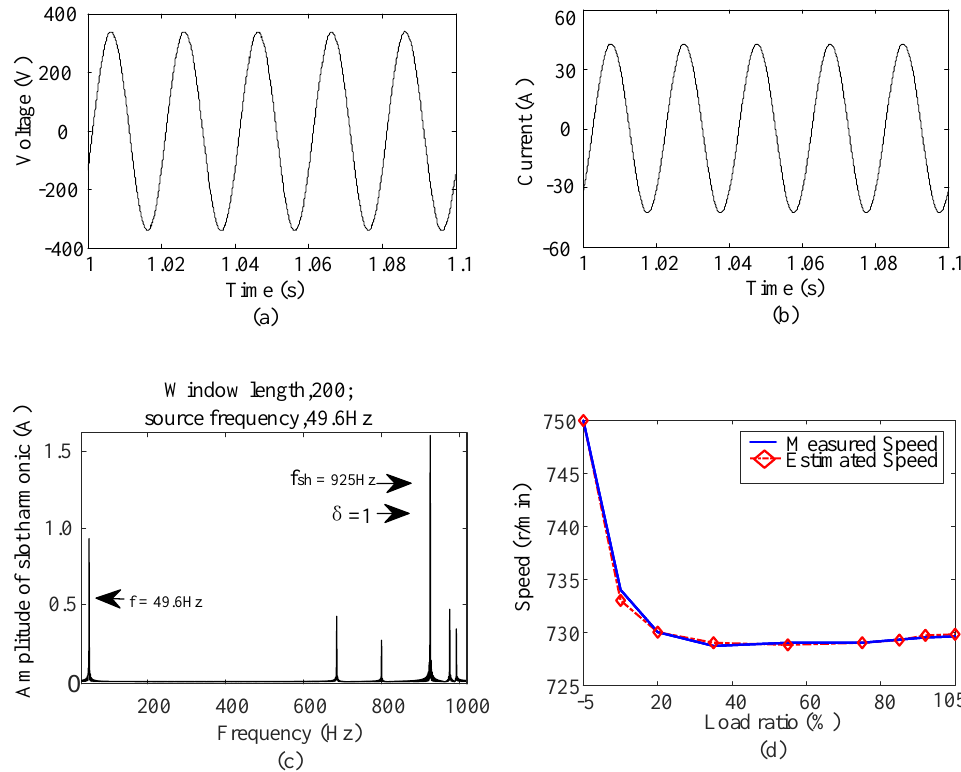
Figure 8. ( a ) Voltage waveform, ( b ) current waveform, ( c ) extracted slot harmonic frequency f sh = 925 Hz, speed n = 729 r/min, ( d ) measured and estimated speeds under different loads condition.